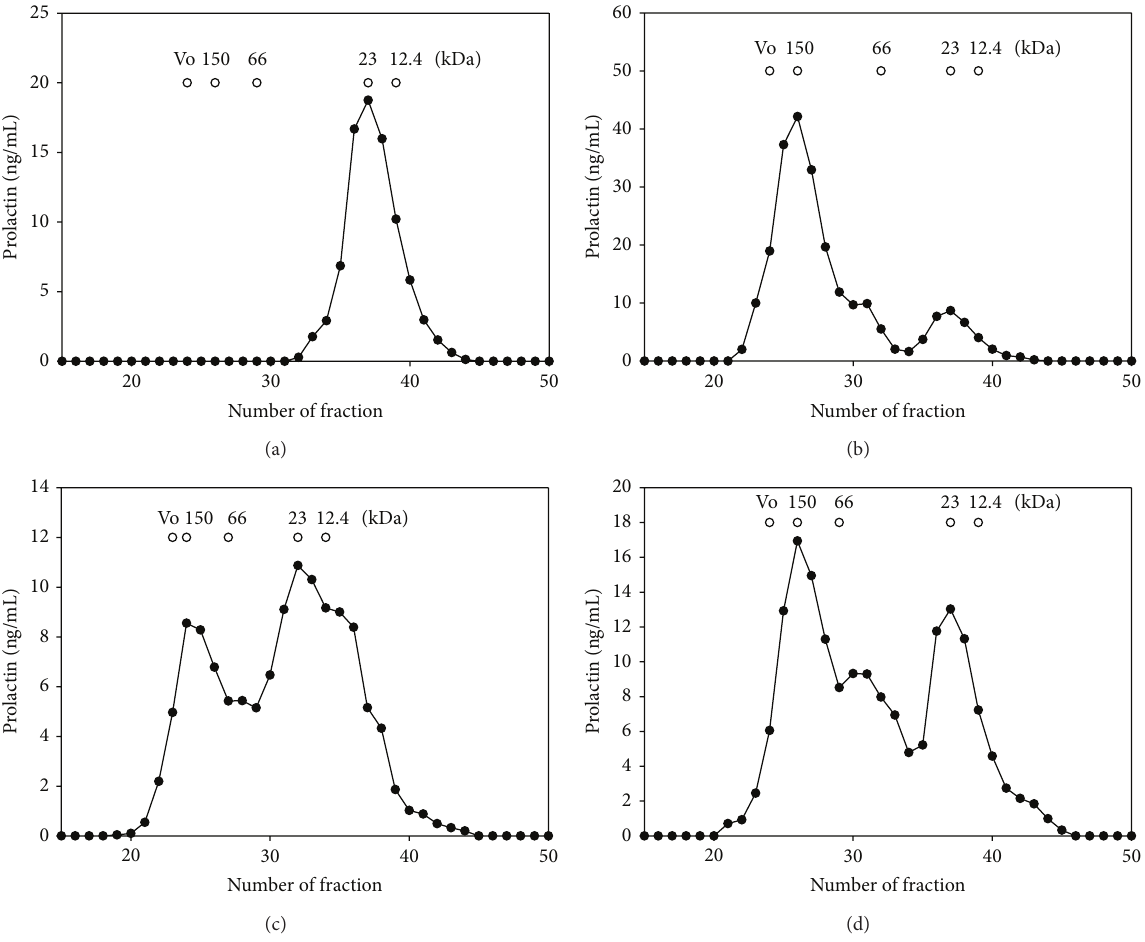
Figure 1: Representative gel filtration profiles of immunoreactive PRL in sera from hyperprolactinemic patients on a Sephacryl HR 200 column ( 60 × 1 cm). Samples (1mL) were applied on the column, and the fractions of 900 𝜇 L were collected. (a) Exclusive or predominant pattern of monomeric PRL (little PRL); (b) exclusive or predominant pattern of macroprolactinemia (big big PRL); ((c) and (d)) variable patterns.